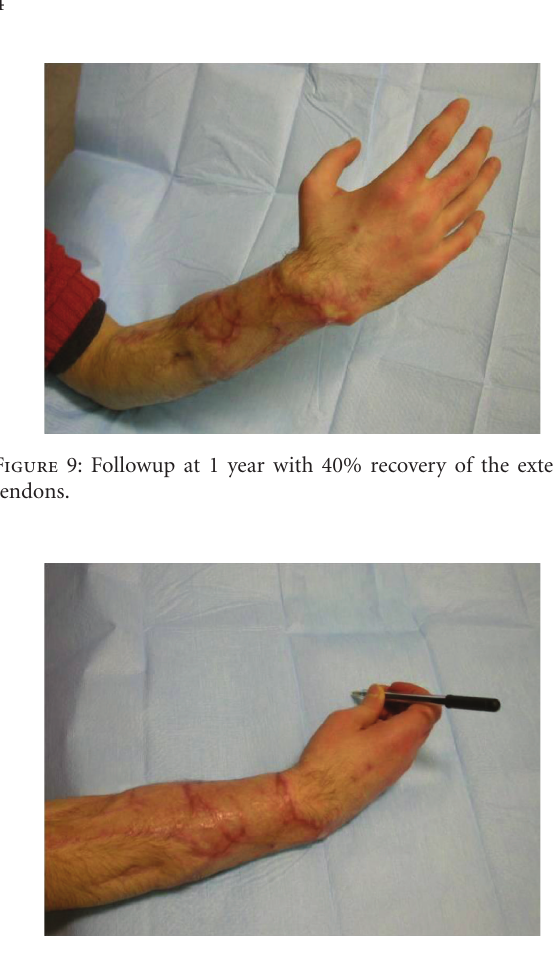
Figure 10: Patient able to write.